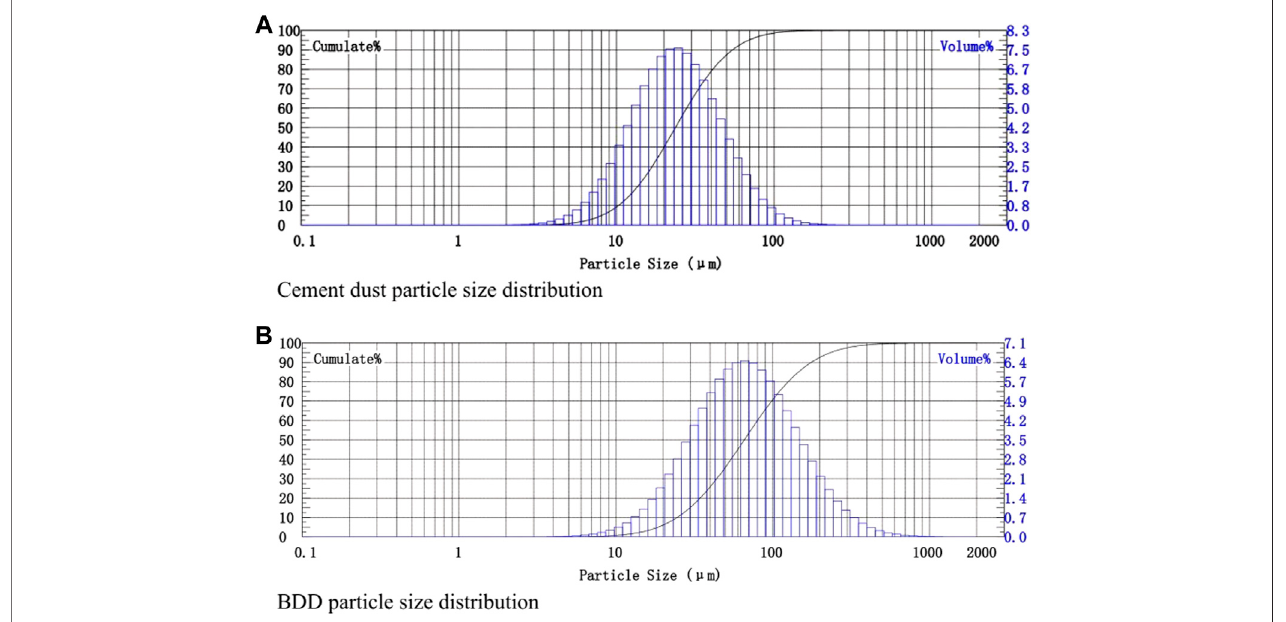
FIGURE 4 | Dust particle size distribution, (A) cement powder and (B) BDD.